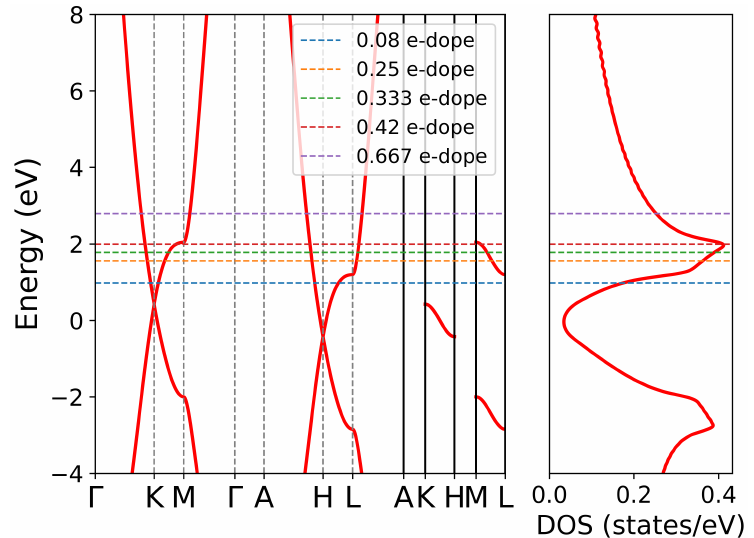
Figure 3. Band structure and Density of States (DOS) at different doping levels in rigid band approximation (RBA). The Fermi level at 0.08, 0.25, 0.333, 0.42, and 0.667 e-dope per unit cell are marked by light blue, orange, green, brown and violet dashed lines, corresponding to E F at 0.98, 1.555, 1.777, 1.992, and 2.793 eV,